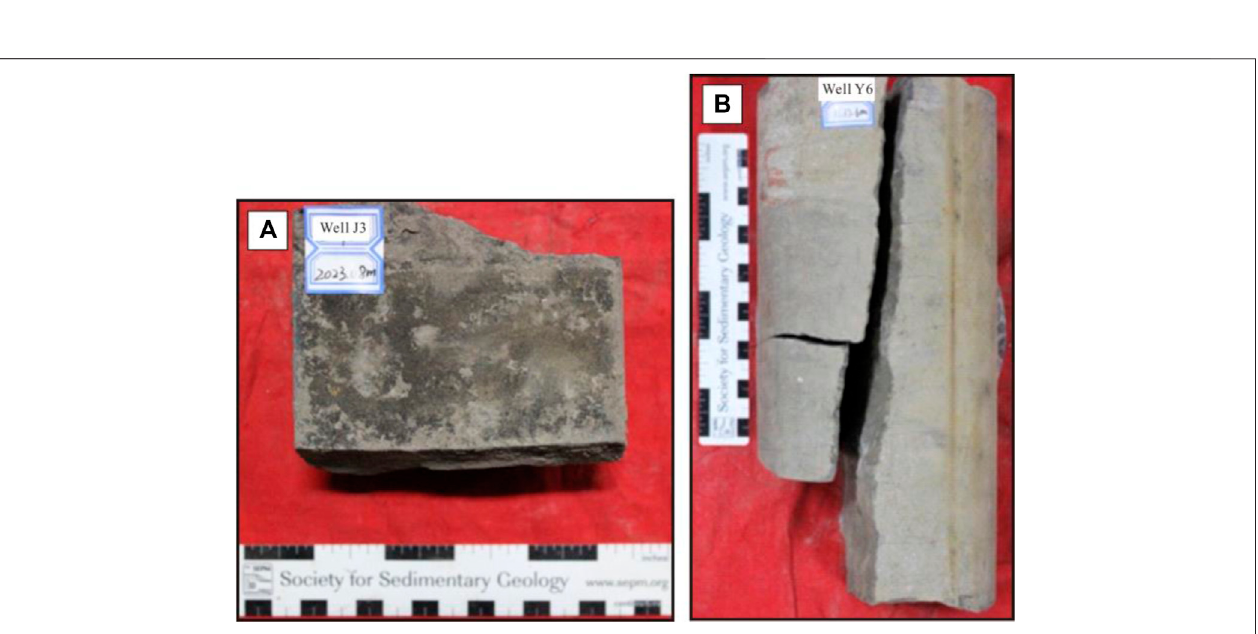
Frontiers in Earth Science |